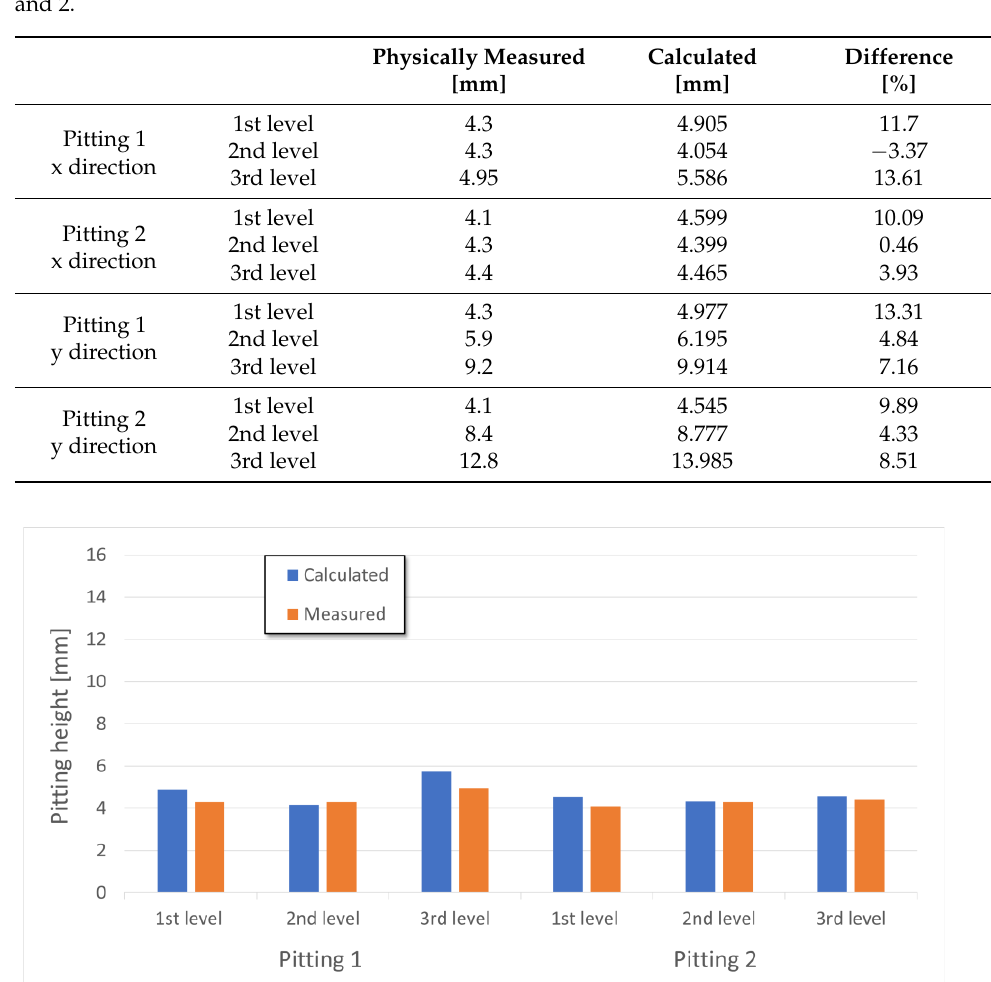
Figure 6. Comparison of the measured and the calculated results for Pitting 1 and 2 in the y direction.